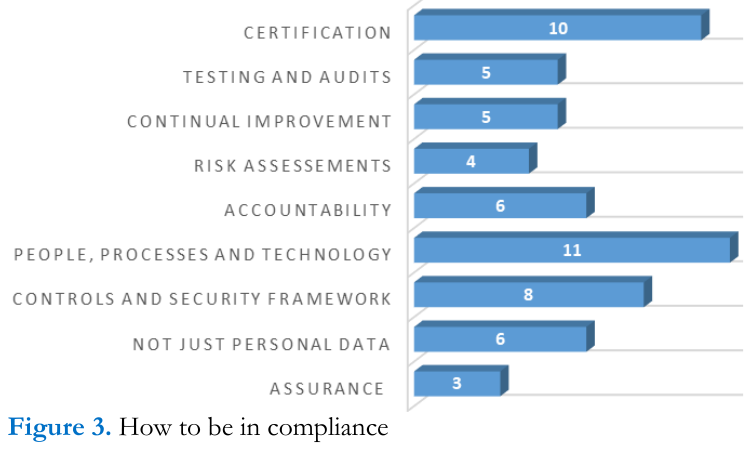
Figure 3. How to be in compliance